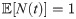
Correspondence between relative parameters estimated using gLV and cLV on three datasets.Each box plot displays the distribution of observed community size (i.e. N(t)) across all samples, rescaled such that E[N(t)]=1. Scatter plots display the relative parameters estimated by cLV (y-axis), and the corresponding difference in parameters of gLV (x-axis). cLV better approximates interactions inferred using gLV when the variability in concentrations is low, matching theoretical expectations. A strong correspondence is observed between external perturbations across all datasets.